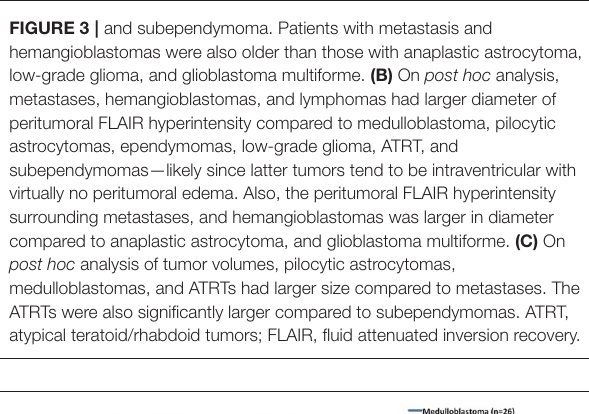
FIGURE 3 | and subependymoma. Patients with metastasis and hemangioblastomas were also older than those with anaplastic astrocytoma, low-grade glioma, and glioblastoma multiforme. (B) On post hoc analysis, metastases, hemangioblastomas, and lymphomas had larger diameter of peritumoral FLAIR hyperintensity compared to medulloblastoma, pilocytic astrocytomas, ependymomas, low-grade glioma, ATRT, and subependymomas—likely since latter tumors tend to be intraventricular with virtually no peritumoral edema. Also, the peritumoral FLAIR hyperintensity surrounding metastases, and hemangioblastomas was larger in diameter compared to anaplastic astrocytoma, and glioblastoma multiforme. (C) On